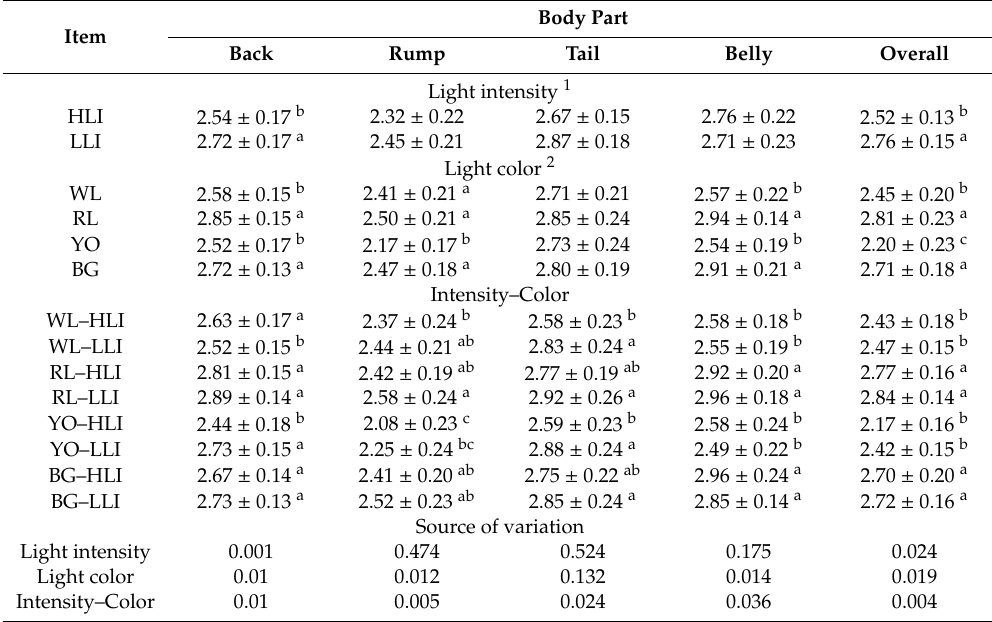
Table 5. Means ( ± SE) of plumage score of hens in response to light colors and light intensities *. Item